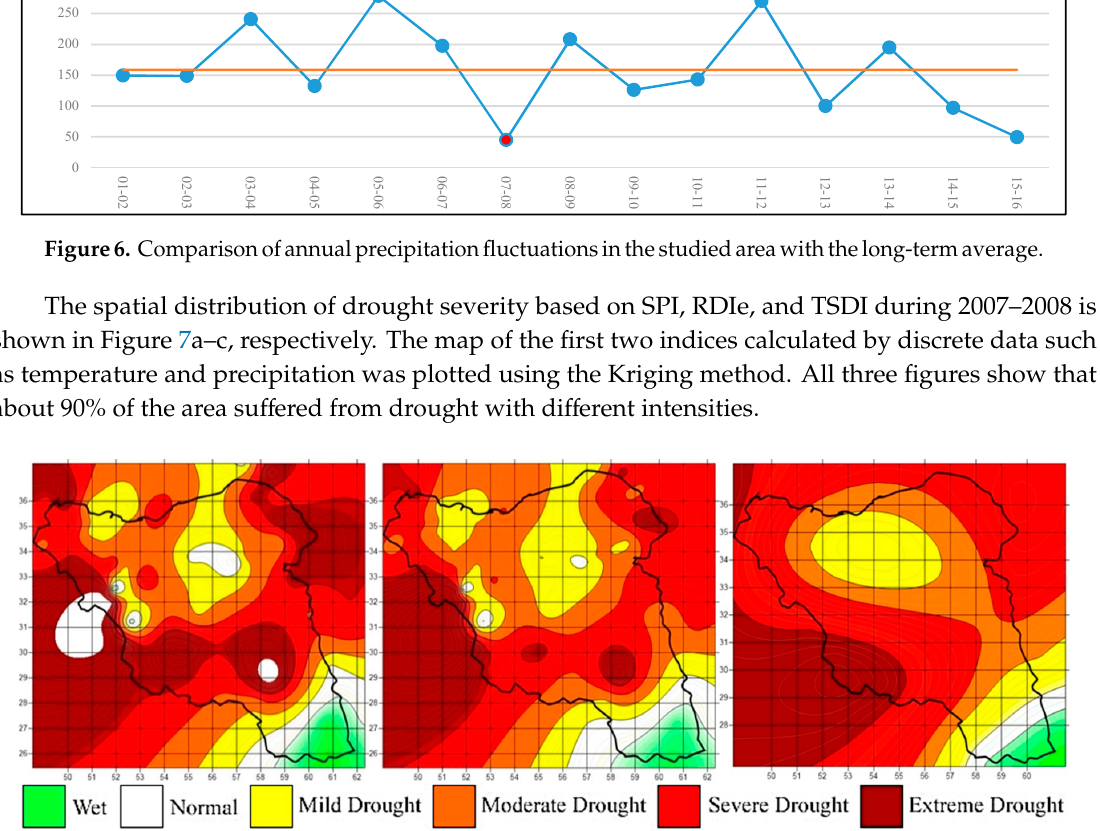
Figure 7. Spatial distribution and drought intensity during the 2007–2008 hydrologic year based on three drought indices. ( a ) SPI; ( b ) RDIe; ( c ) TSDI.